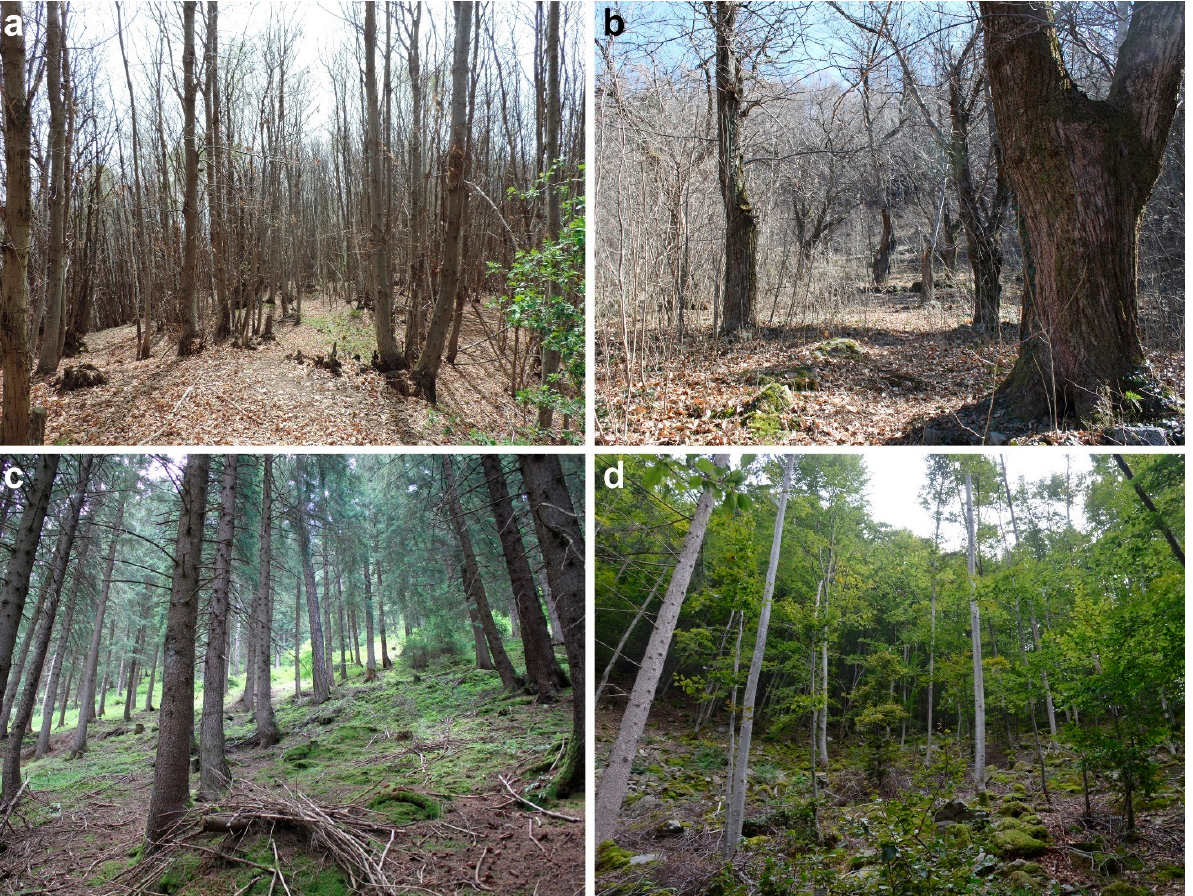
Figure 5. Chestnut sampling plots are representative of different forest management systems including ( a ) coppice and ( b ) high forest. Most of the spruce stands have been changing their structure, but, in some cases, the results from the R aggregation index reveal the original reforestation design with a grid pattern and uniform distances among trees ( c : one of the analyzed spruce stands). Beech forest has been usually managed as coppice for firewood. However, forest managers now prefer to convert the coppice system to even-aged high forest ( d : beech coppice conversion to high forest).